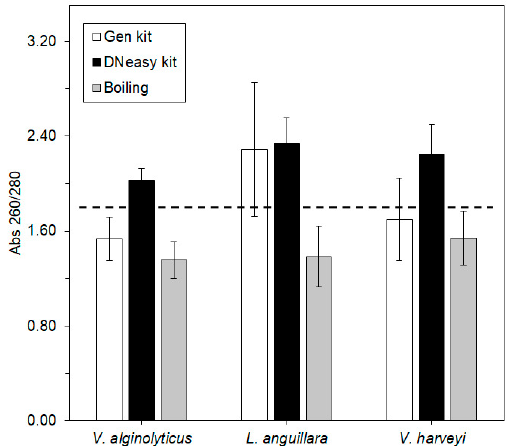
Figure 2. Purity of extracted DNA of V. alginolyticus, L. anguillara , and V. harveyi using three DNA extraction methods assessed by the ratio of absorbances at 260 and 280 nm: —Gen kit, — DNeasy kit, and —boiling. The dashed line denotes the threshold ratio of 1.80, above which DNA is considered pure. Error bars ± standard error.